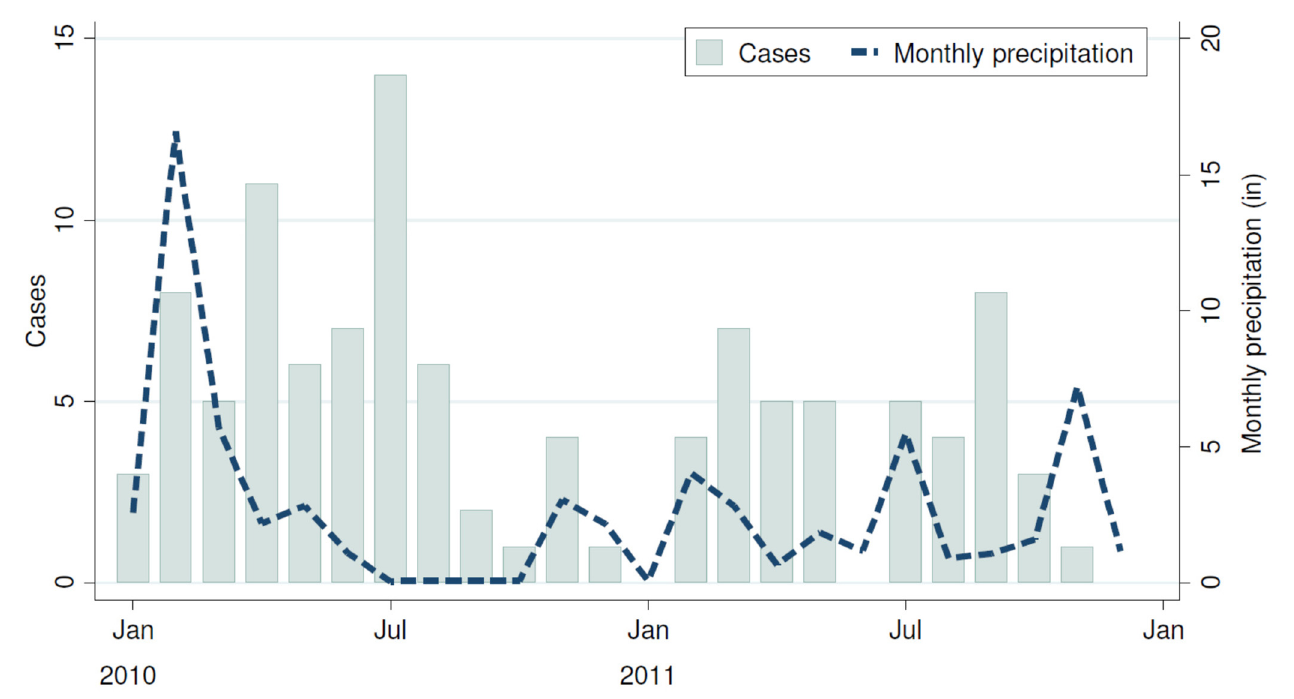
Fig 3. Monthly distribution of 110 incident typhoid cases between 2010 – 2011 in Kibera with monthly precipitation overlaid.